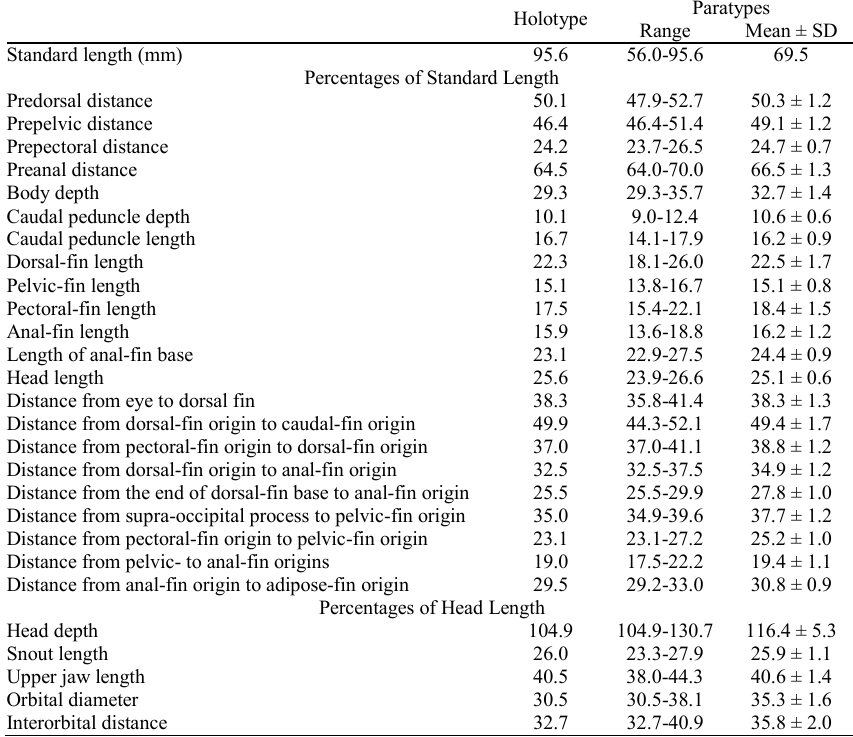
Table 1. Morphometric data of Astyanax guaricana . SD = Standard deviation, N =